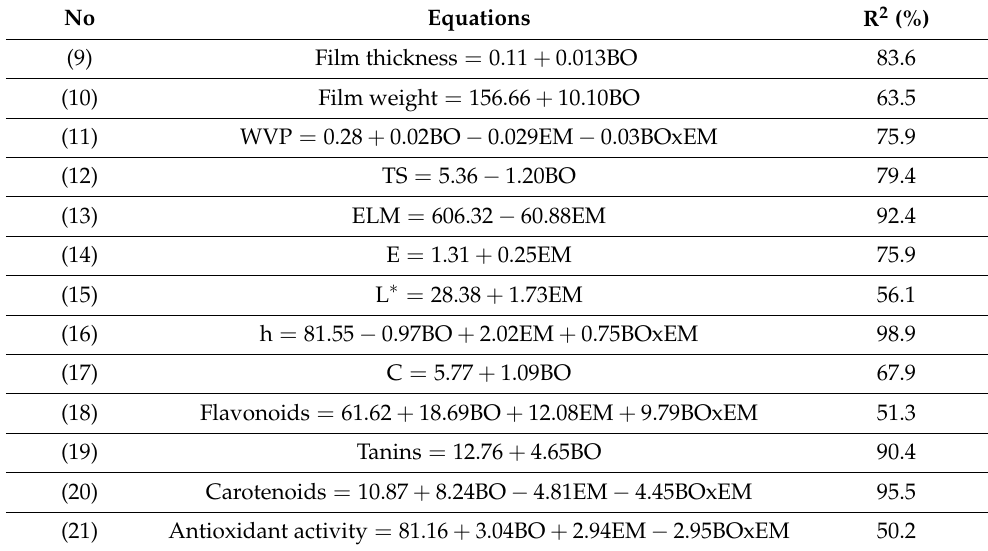
Table 2. Mathematical modeling of the dependent variables (film thickness, film weight, WVP, tensile strength (TS), elasticity modulus (ELM), and elongation (E), color parameters (L*, h, and C), bioactive compounds (flavonoids, tannins, carotenoids), and antioxidant activity of the films) according to the results obtained through experiments using the independent variables (buriti oil = BO and emulsifier =